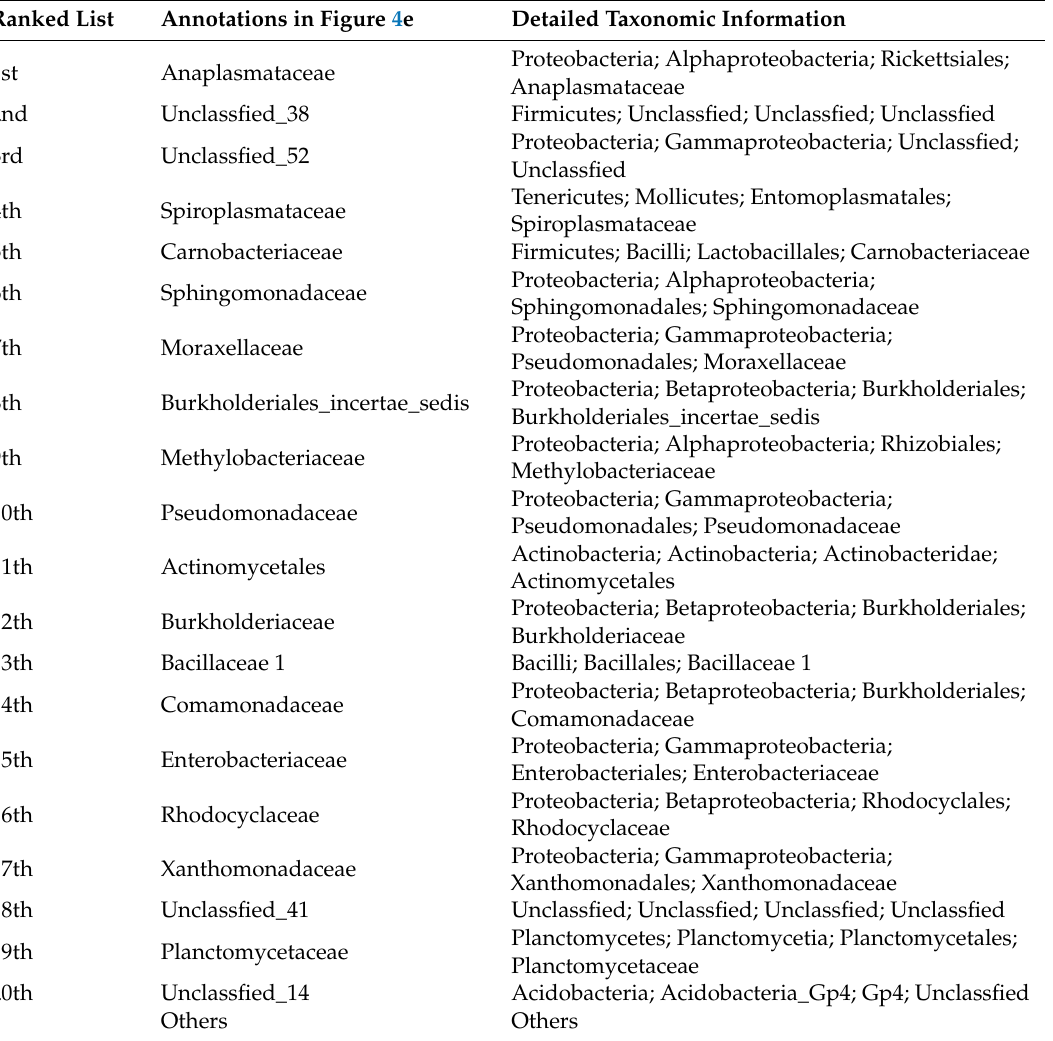
Table A2. The detailed taxonomic information of the top 20 bacteria of unfertilized eggs on family rank.